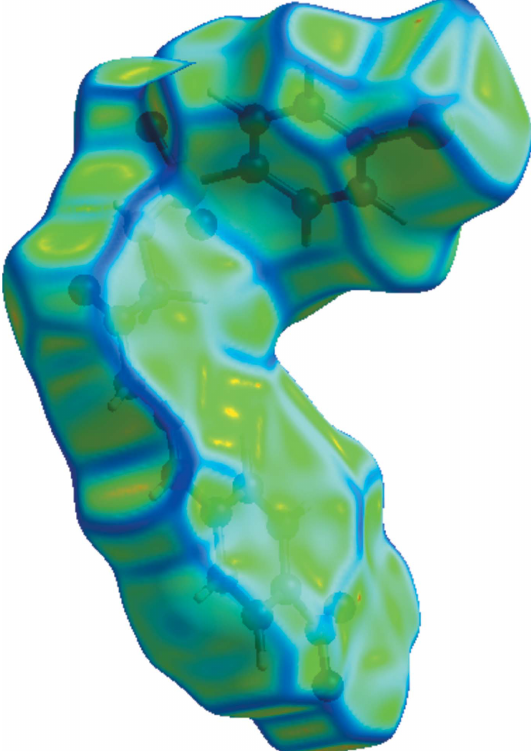
Figure 8 View of the Hirshfeld surface mapped over